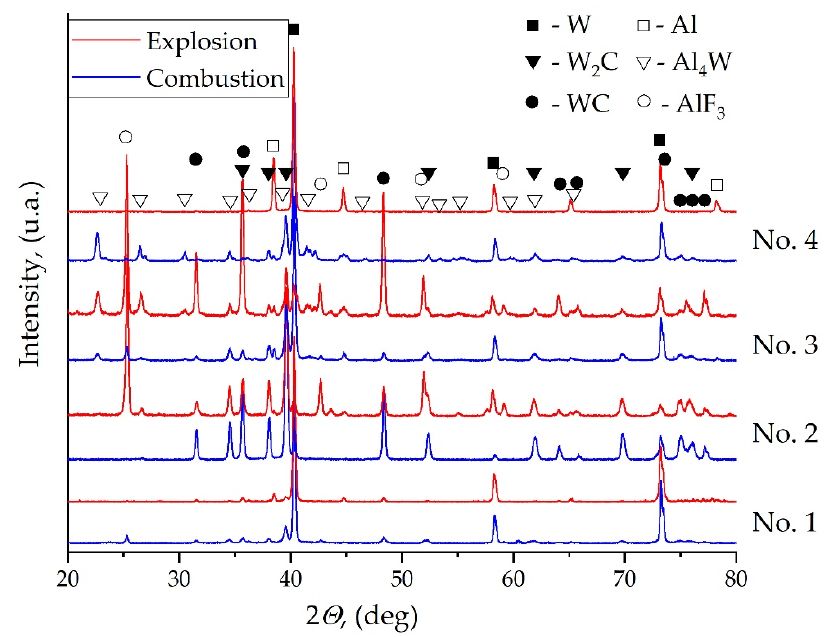
Figure 12. XRD patterns of the products (of compositions No.1–4) synthesized from the W/PTFE/Al specimens after combustion (Ar) and shock-wave initiation.